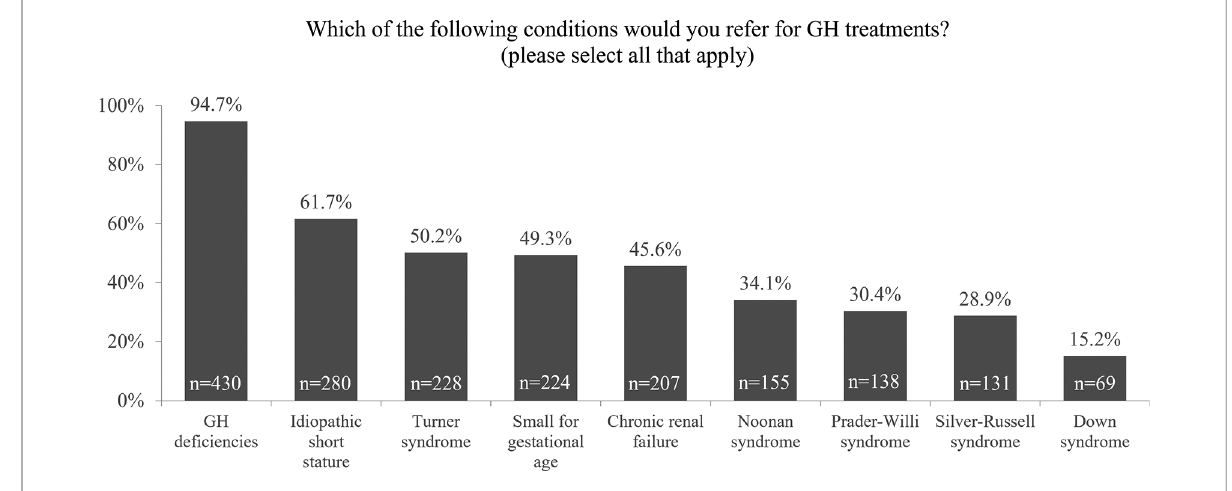
FIGURE 4 Survey responses to “ Which of the following conditions would you refer for GH treatment? ” . GH, growth